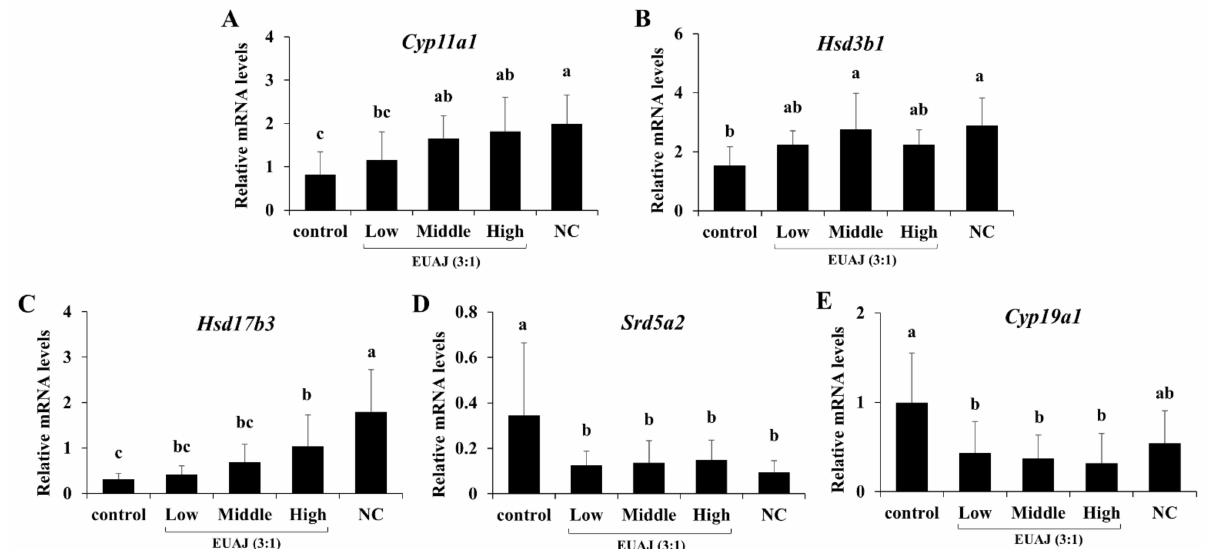
Figure 5. The effects of EUAJ (3:1) on mRNA expressions of steroidogenic enzymes involved in testosterone synthesis in testis of SD rats. mRNA expressions level of steroidogenic genes related to testosterone synthesis ( A – C ) and testosterone degradation ( D , E ) were measured by quantitative real-time PCR. Values are presented as means ± SD. Different superscript letters show a significantly difference at p < 0.05, as determined by Duncan’s multiple range test. Control; saline, low; EUAJ (3:1) 20 mg/kg, middle; EUAJ (3:1) 40 mg/kg, high; EUAJ (3:1) 80 mg/kg, NC; saline.